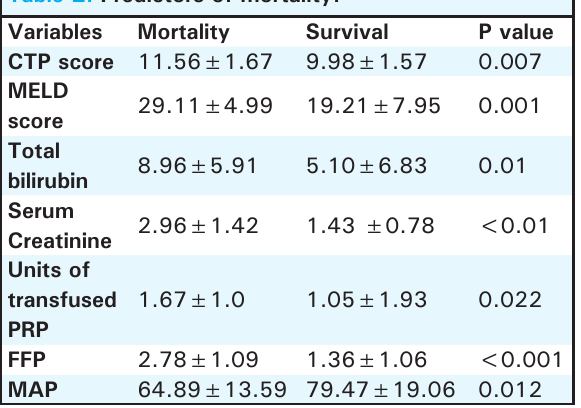
Table 2. Predictors of mortality.